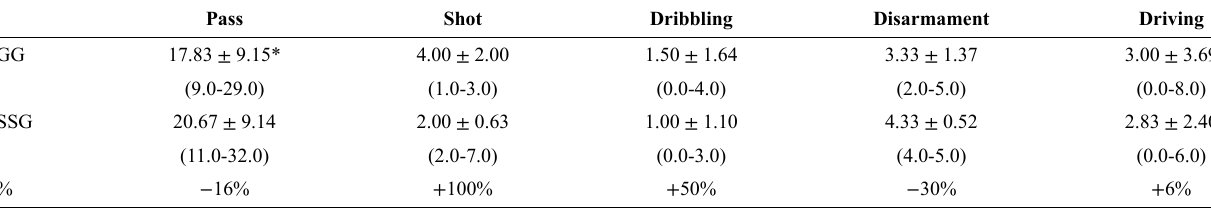
Table 1 - Comparison of average number of specific technical actions performed in GG and SSG.